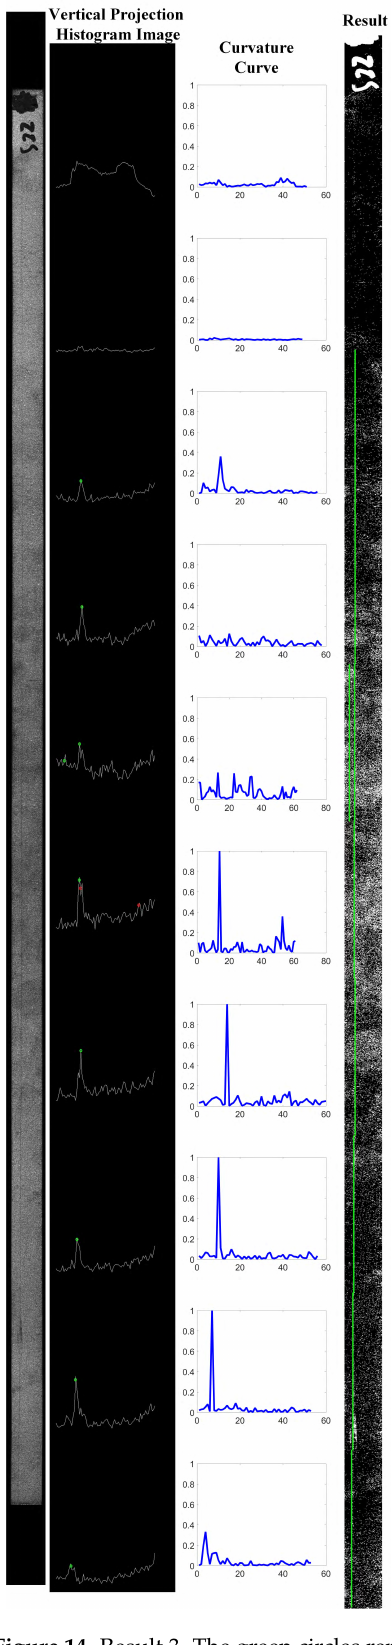
Figure 14 Figure 14. Result 3. The green circles represent local maximums, red circles represent local valleys, and the green lines represent the detected